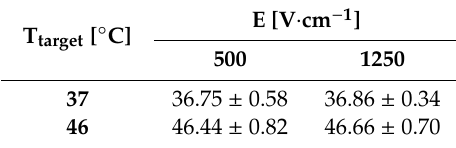
Table 2. The mean temperature over the treatment time (n = 3; including ± SD) acquired from the treatments as a function of target temperature (T target [ ◦ C]) and electric-field strength (E [V · cm − 1